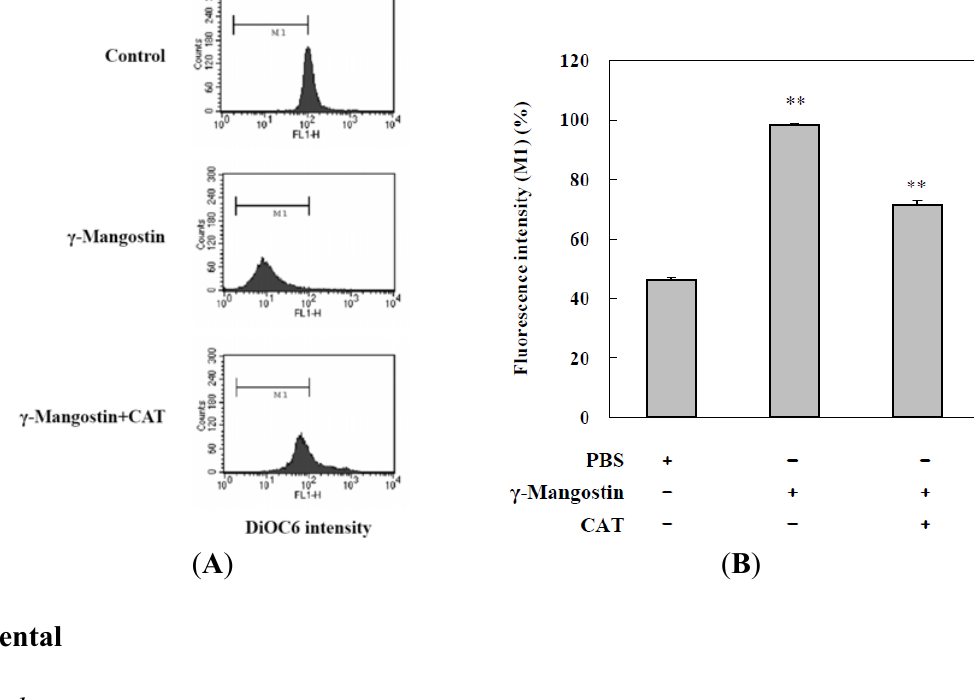
Figure 4. Catalase (CAT) prevented potential γ -mangostin-induced mitochondrial